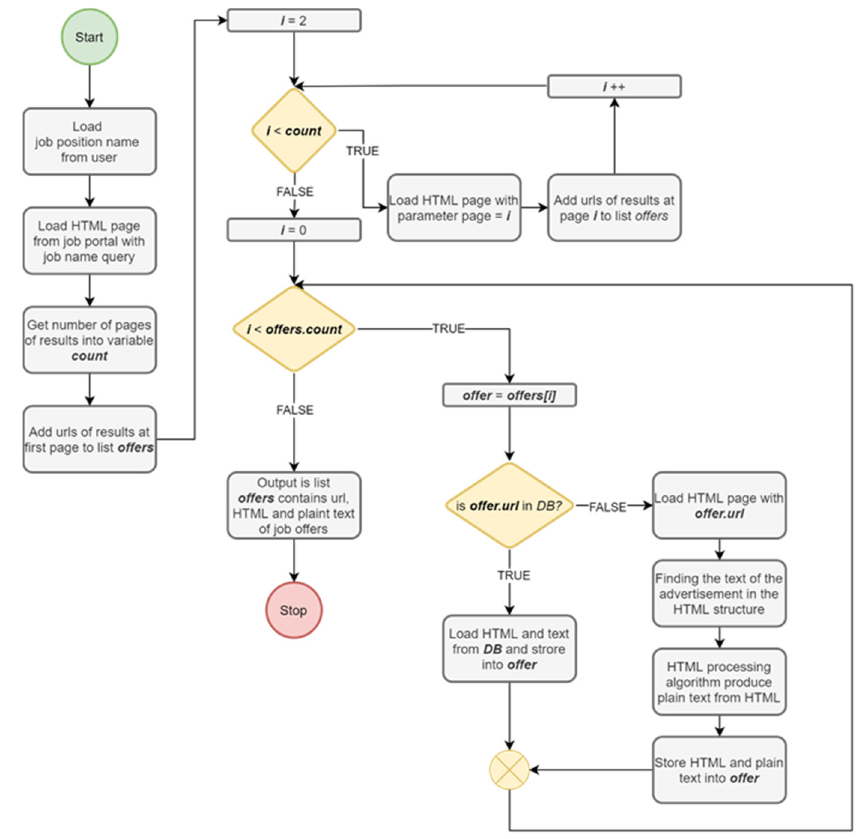
Figure 3. Data mining process from job advertisements.